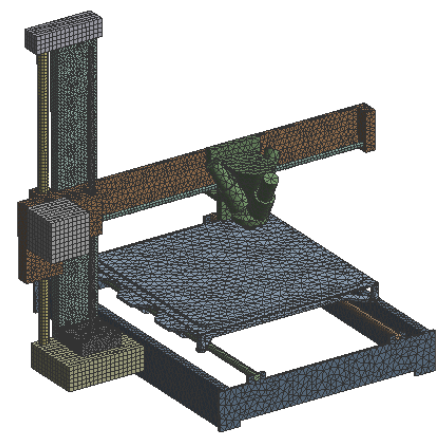
Figure 6. The finite element model of the color 3D printer.